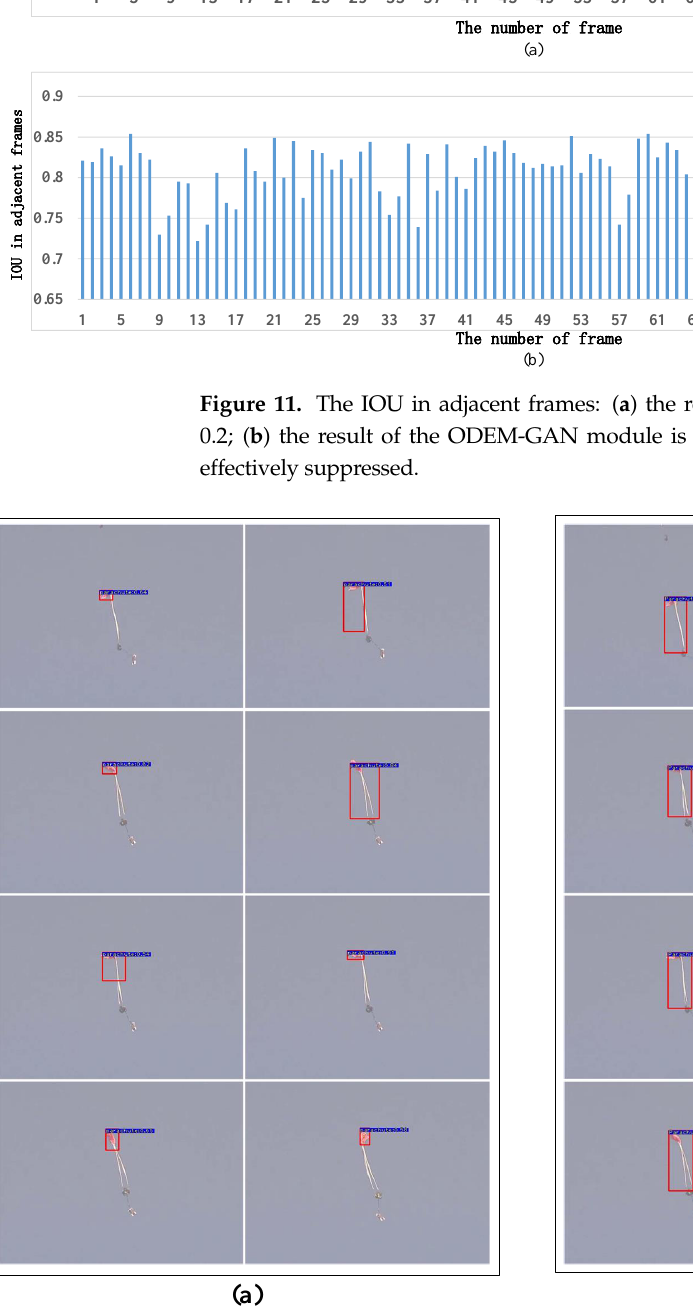
Figure 12. Visualization of the IOU in adjacent frames result: ( a ) the RetinaNet with CBAF module; and ( b ) the RetinaNet with ODEM-GAN